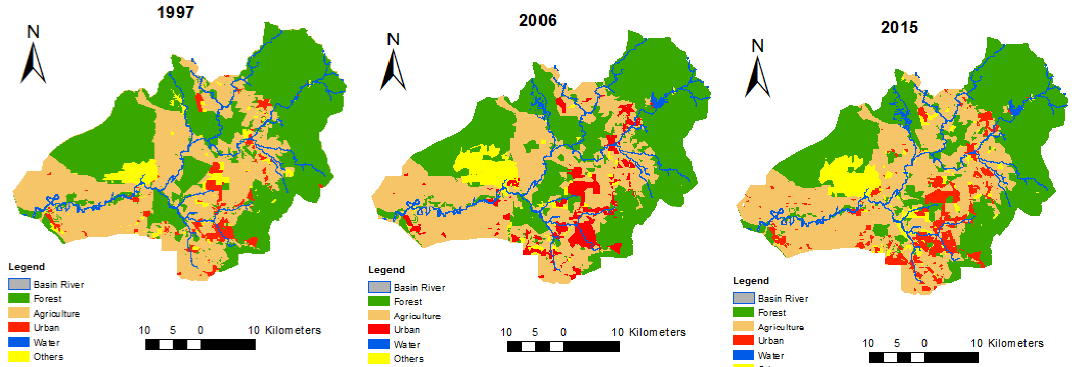
Fig. 2: Land-use maps: 1997, 2006, and 2015 (DOA, 2019)